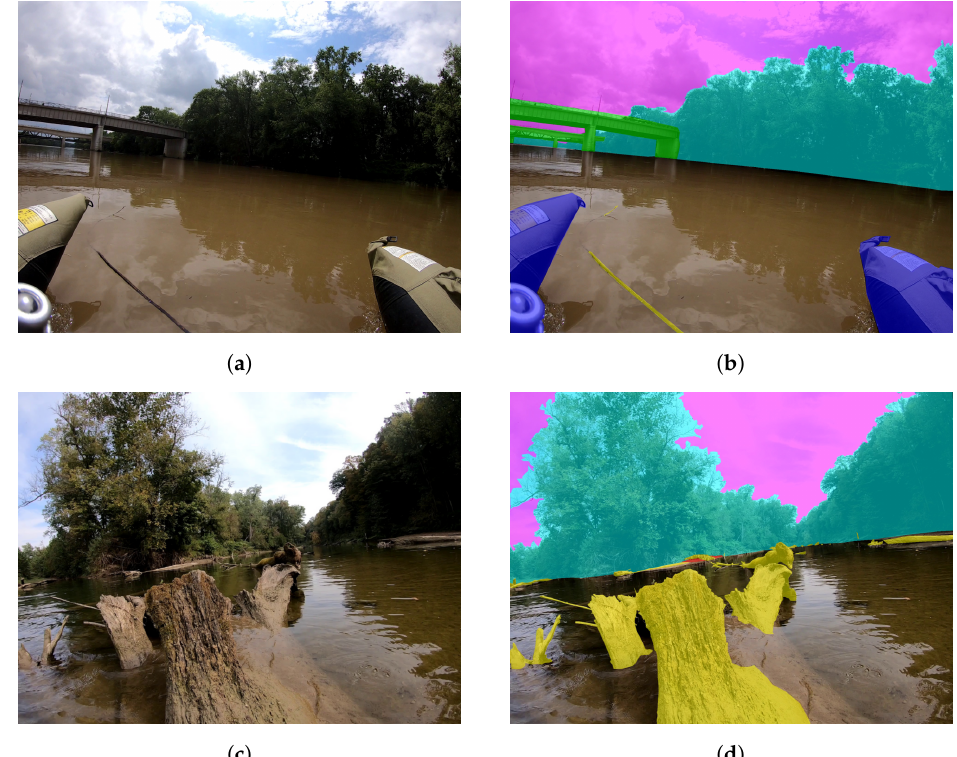
Figure 1. ( a ) Image captured on the Wabash River from a USV going through downtown Lafayette in Tippacanoe County, Indiana, ( b ) Annotation of ( a ) showing segmentation of the fluvial scene with annotations of bridge, sky, obstacles, and trees (river is disjoint of other classes), ( c ) Image captured from a canoe on Sugar Creek in Parke County, Indiana, ( d ) Annotation of ( c ) showing the annotation of the fluvial scene with annotations of the sky, trees, obstacles, and sandbar/riverbed